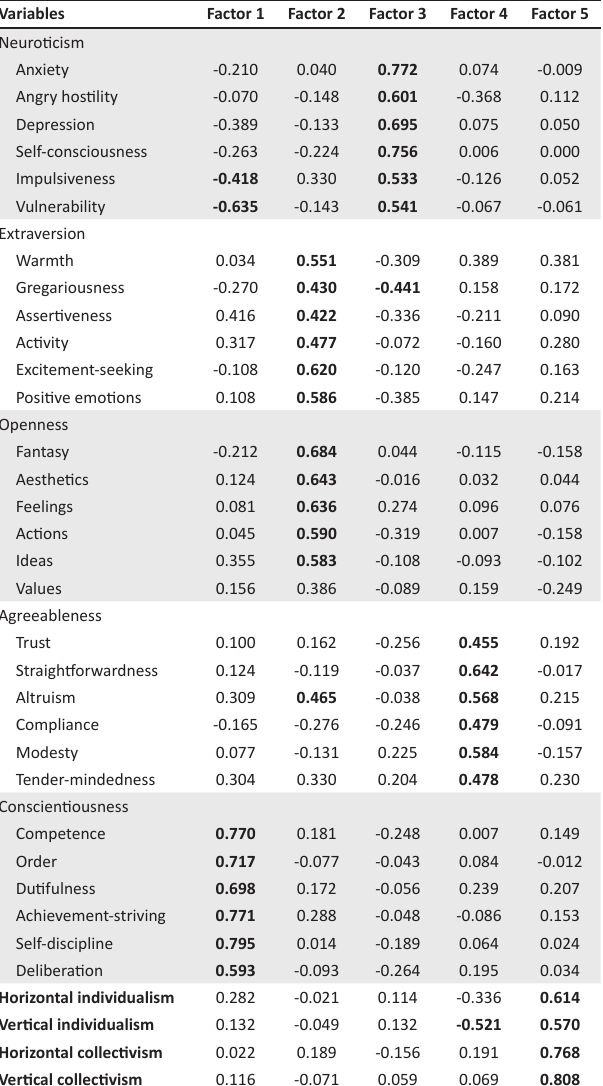
TABLE 4: Five-factor solution for the joint factor analysis of the NEO-PI-3 and the individualism and collectivism dimensions. Variables